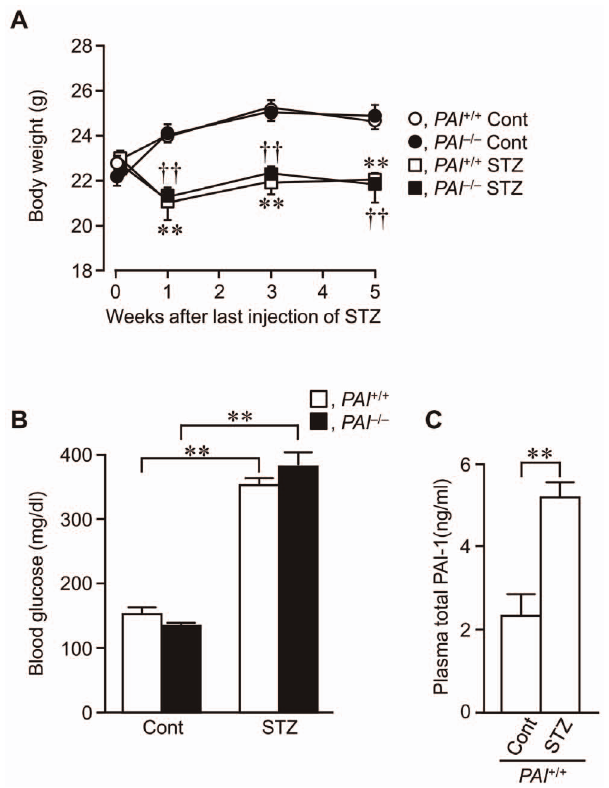
Figure 1. Effects of streptozotocin (STZ) treatment on body weight, blood glucose, and plasma PAI-1 levels in female mice. (A) Growth curve during experiments in control (Cont) and STZ-treated female PAI-1 + / + and PAI-1 2 / 2 mice. Results are expressed as the means 6 SEM. ** p , 0.01 vs. the PAI-1 + / + control group, {{ p , 0.01 vs. PAI-1 2 / 2 control group. (n=5 in each group). (B) Blood glucose in control and STZ-treated female PAI-1 + / + and PAI-1 2 / 2 mice. Results are expressed as means 6 SEM. ** p , 0.01 (n=5 in each group). (C) Plasma total PAI-1 levels in control and STZ-treated female PAI-1 + / + mice. Results are expressed as means 6 SEM. ** p , 0.01 (n=5 in each